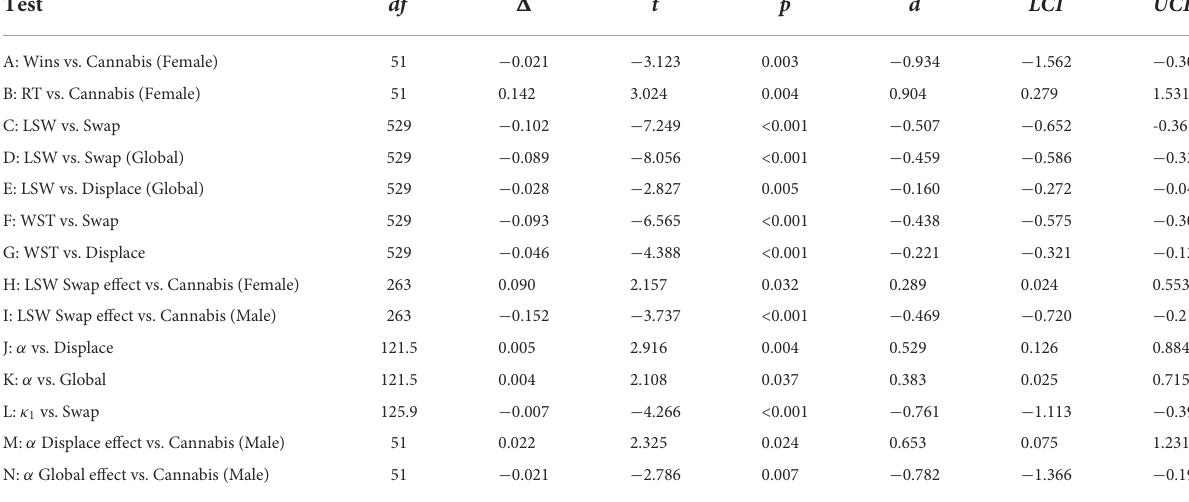
TABLE 2 Table summarizing key significant effects.